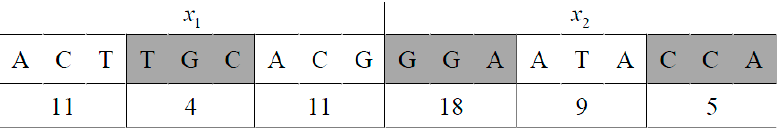
Figure 1. The coding for two variables.